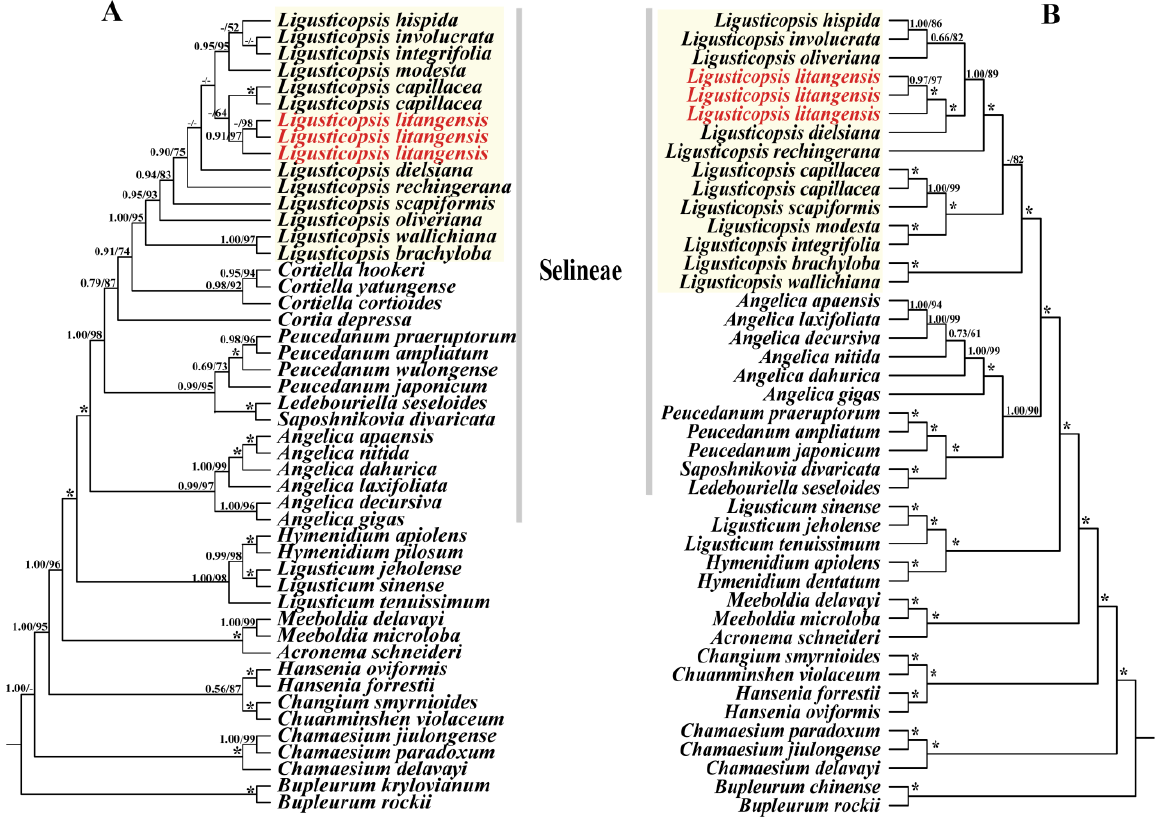
Figure 9. Phylogenetic relationships of Ligusticopsis and its related genus inferred from ( A ) ITS and ( B ) CDS based on ML and BI methods. ML BS (bootstrap) and BI PP (posterior probability) values are shown above the branches. The short line denotes values <50%. * = maximum support in both analyses. Red markers represent new species, and yellow markers represent branch of the genus Ligusticopsis